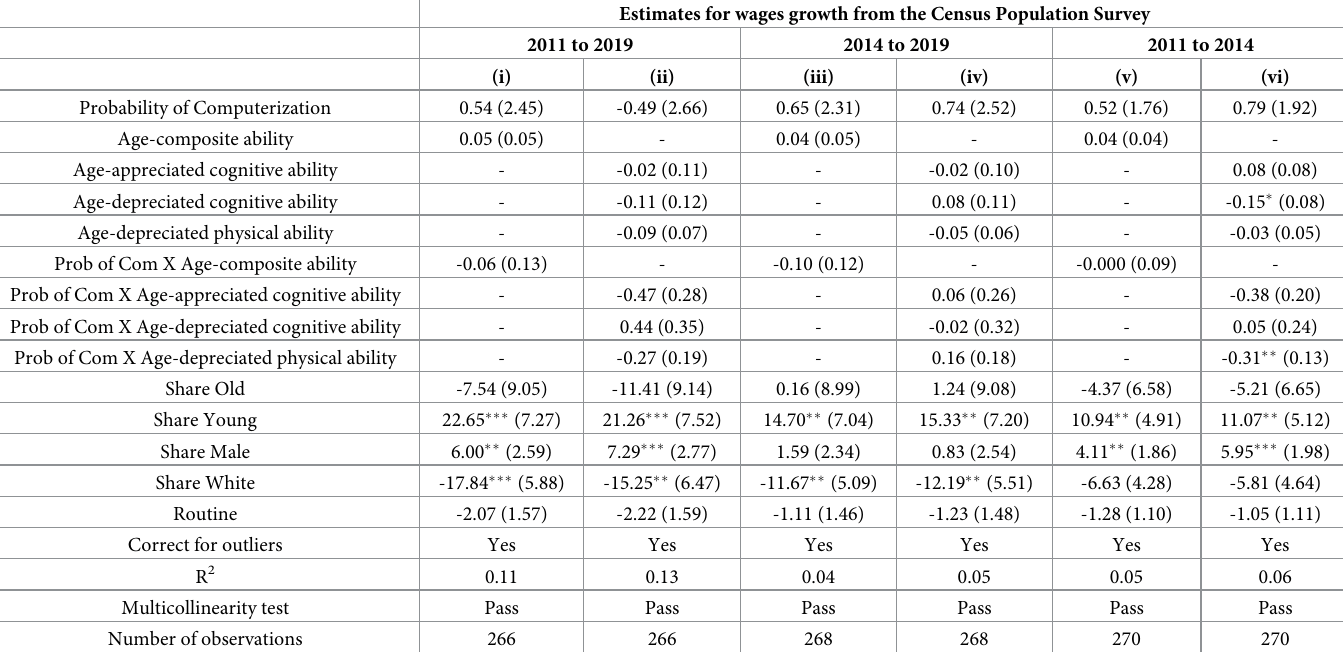
Table 4. The impact of the computerization and age-appreciation or age-depreciation on wages (median weekly